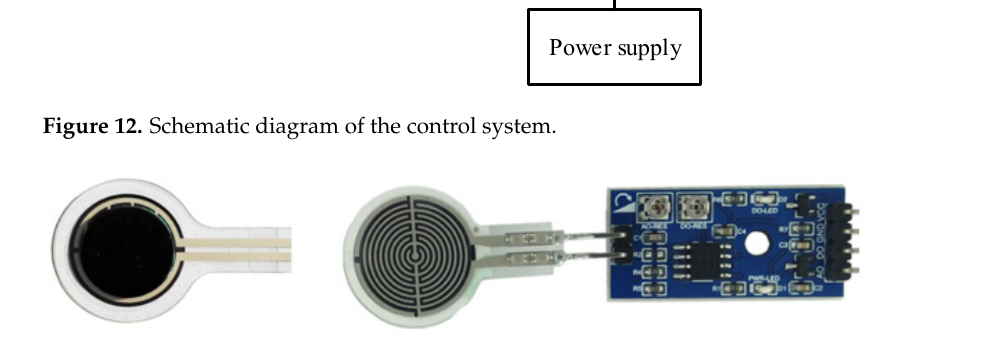
Figure 13. Thin-film pressure sensors and transmitters. Table 2. Resistive film pressure sensor parameter Table 2. Resistive film pressure sensor parameter table.